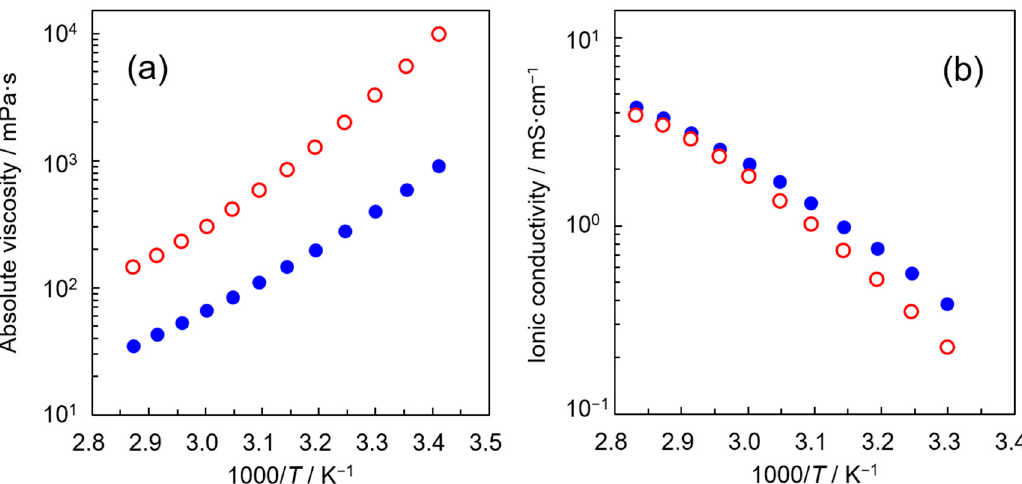
Figure 4. Arrhenius plots of ( a ) absolute viscosity and ( b ) ionic conductivity of 1-allyl-1-(oxiran-2- ylmethyl)piperidinium-based ILs ( ● ) 1 and ( ○ ) 2 . Table 3. Activation energies for the 1-allyl-1-(oxiran-2-ylmethyl)piperidinium-based ILs determined from the Arrhenius plots for absolute viscosity and ionic conductivity.